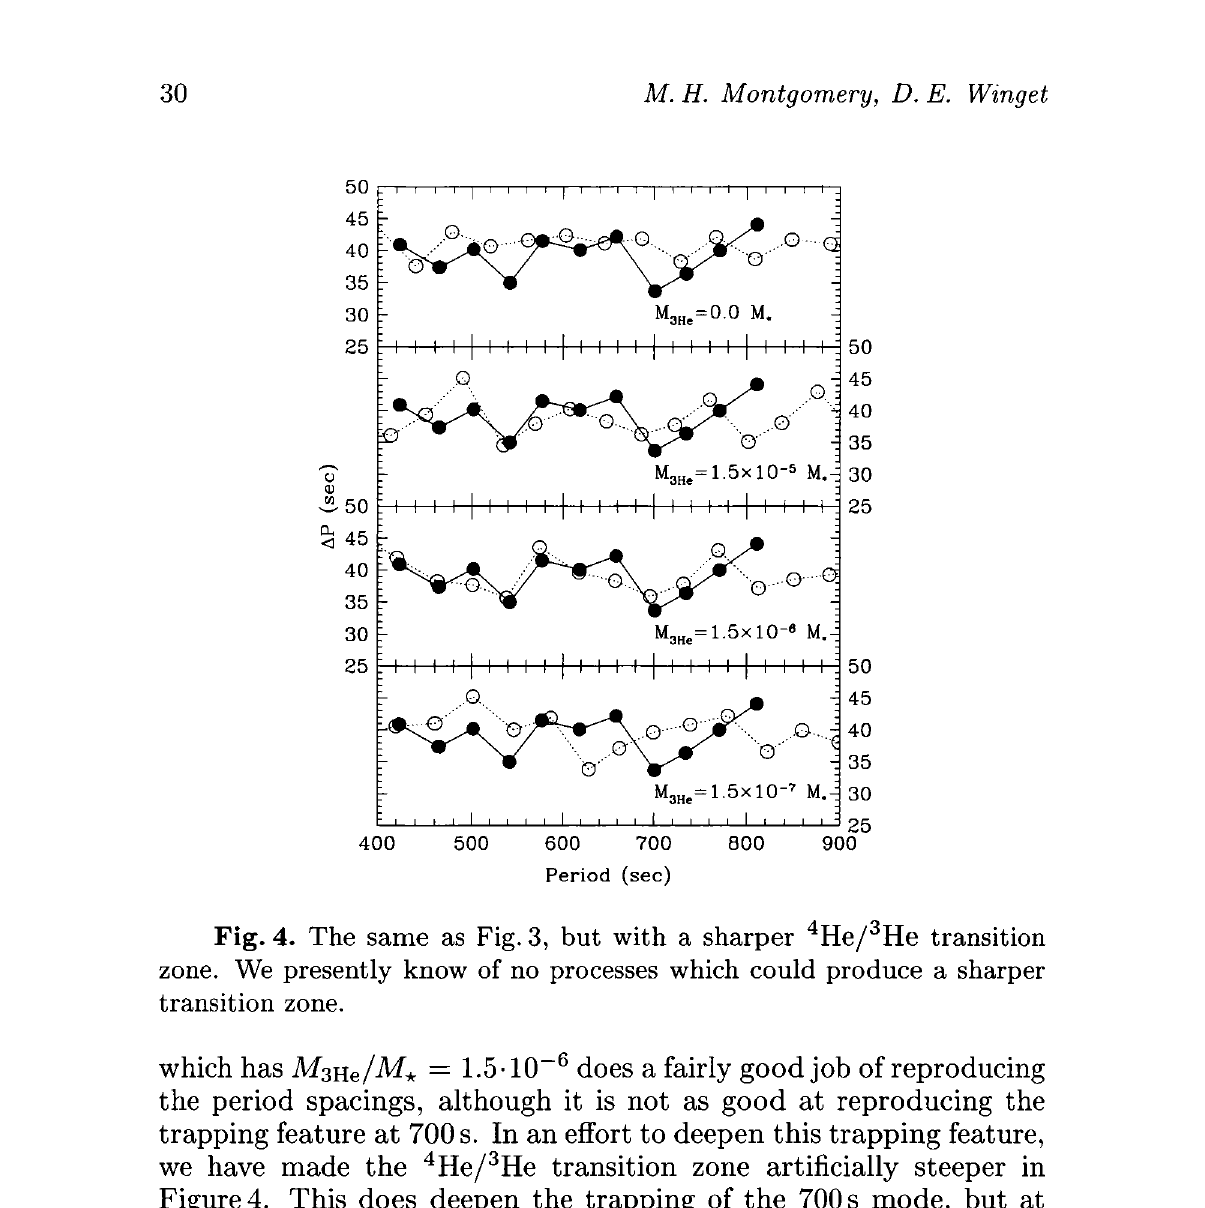
Fig. 4. The same as Fig. 3, but with a sharper 4 He/ 3 He